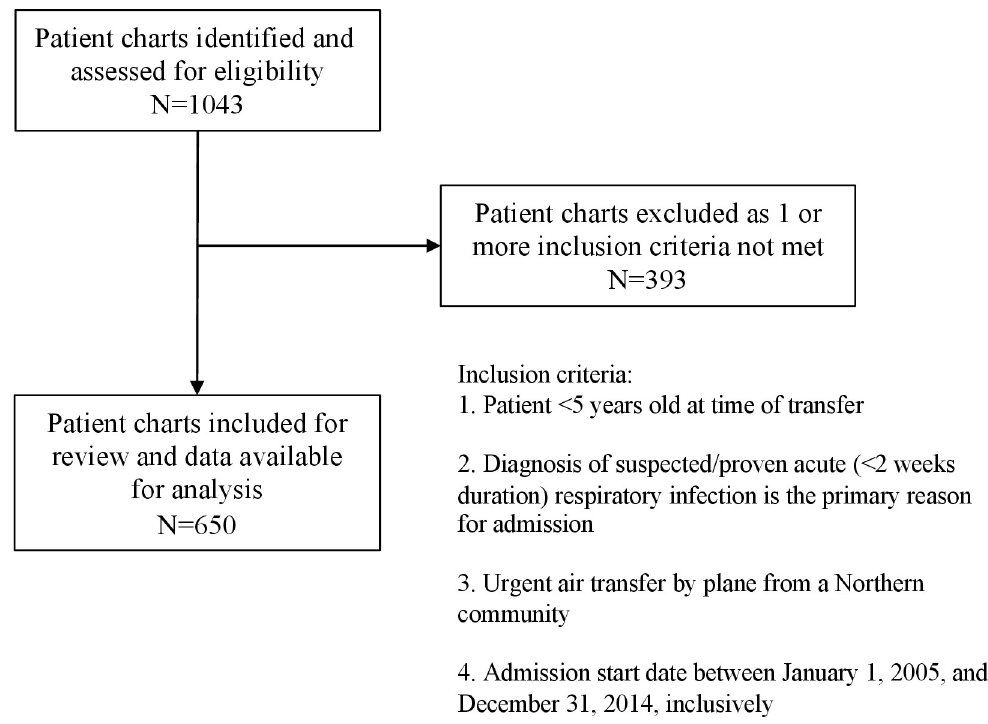
Fig 1. Flow diagram of patient charts.